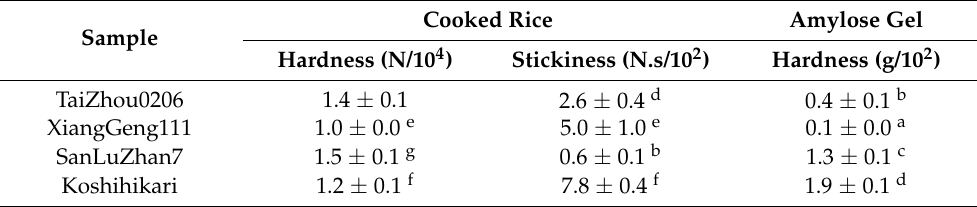
Table 4. Textural properties (hardness and stickiness) of cooked rice and amylose gels. Cooked Sample